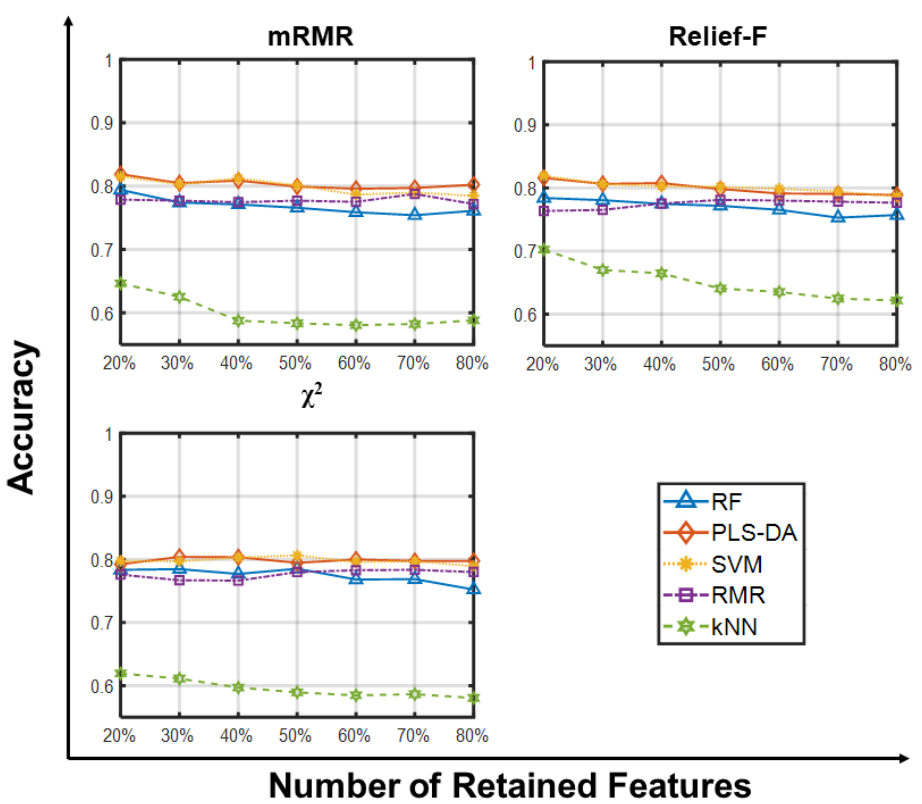
Figure 6. Predictive accuracy retaining larger sets of retained features on CLL__SUB_111. Predictive accuracies of RF, PLS-DA, SVM, RLR and kNN vs. Number of Retained Features (20, 30, 40, 50, 60, 70, 80% of the whole gene set) on the GLI_85 dataset using three feature selection methods. Each point is the average predictive accuracy computed over 100 resamplings. Table 1. Average ± 95% confidence interval (%) assumed by each metric. Classification was per- formed using RF, PLS-DA, SVM, RLR/RMR and kNN on sets of 20 features selected using Relief-F. Results were computed over 100 resamplings. Best values for each combination of classifier/dataset are